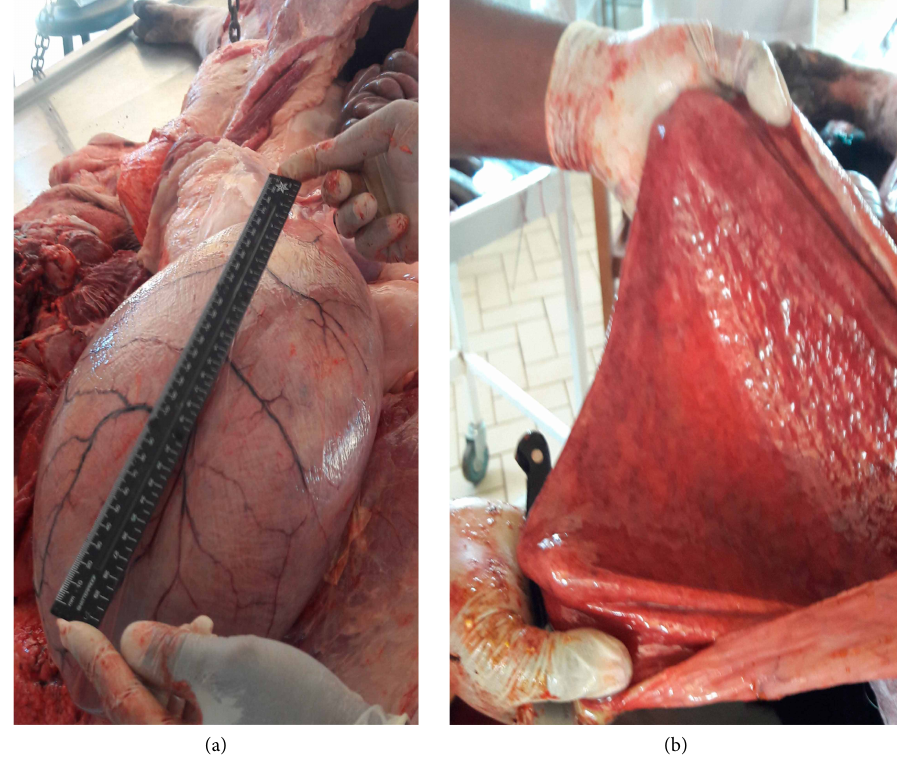
Figure 8: A very distended bladder (a), and congested mucosa of the bladder that was filled with reddish-brown urine